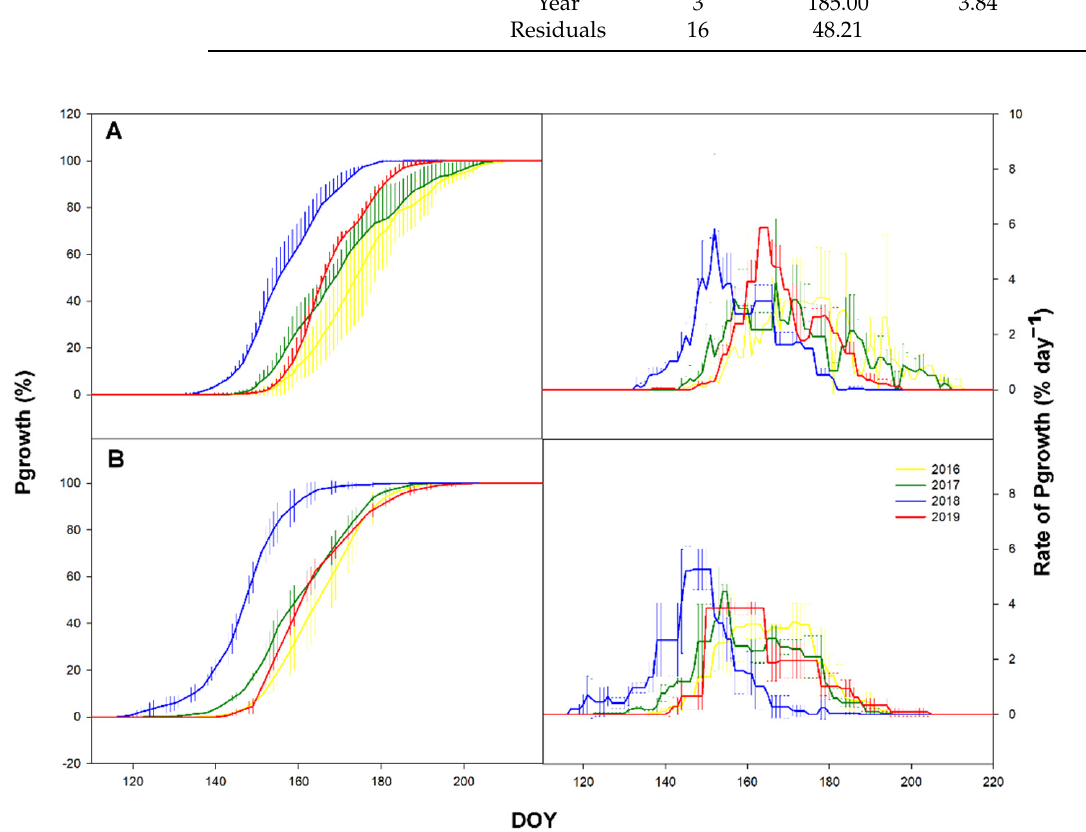
Figure 4. Time series of cumulative daily primary growth (P growth ) in % ( left ) and time series of daily rate ( right ) in % day − 1 at the ESP Bily Kriz ( A ) and Rajec ( B ) in 2016 – 2019. Vertical bars repre- sent standard deviation.